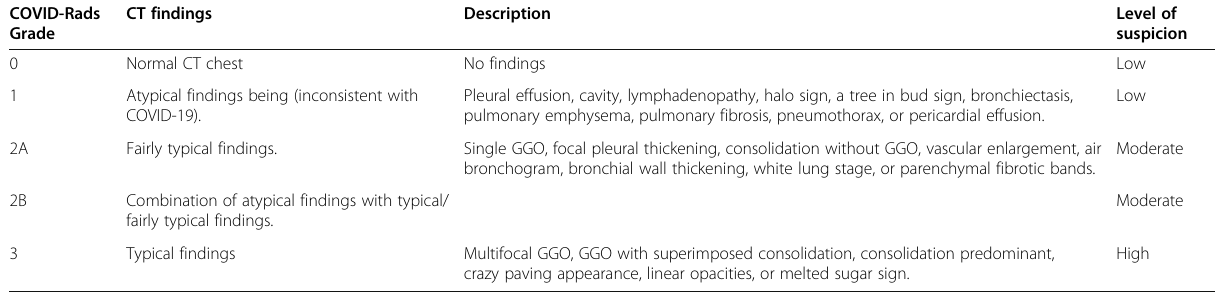
Table 1 COVID-19 imaging reporting and data system classification